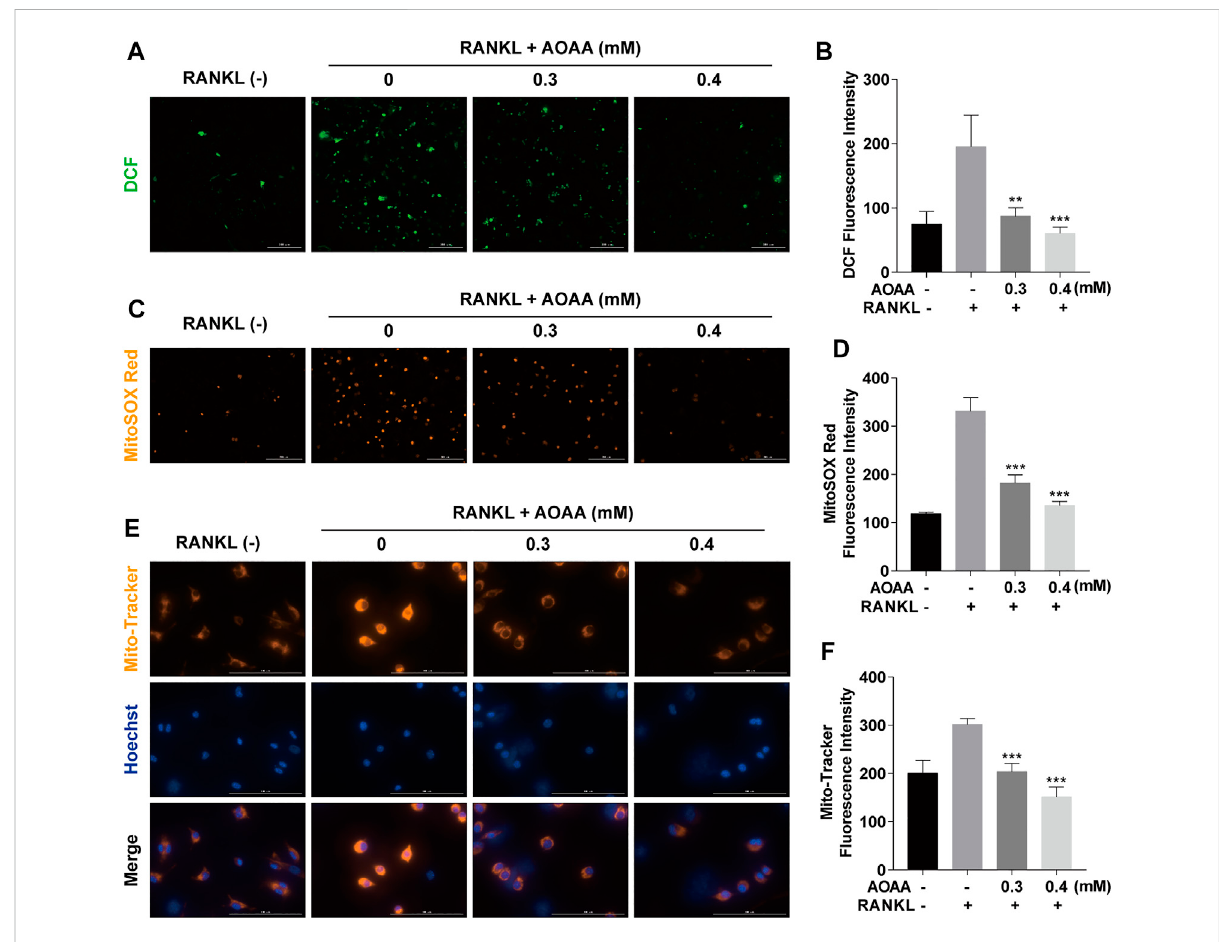
FIGURE 5 AOAA inhibits RANKL-induced ROS and attenuates mitochondrial function. (A) Representative fl uorescence images of RANKL-induced ROS (green, DCF, scale bar = 300 µM). (B) Quanti fi cation of the DCF fl uorescence intensity per fi eld. (C) Representative fl uorescence images of mitochondrial ROS (orange, MitoSOX Red, scale bar = 200 µM). (D) Quanti fi cation of the MitoSOX Red fl uorescence intensity per fi eld. (E) Representative fl uorescence images of mitochondrial membrane potential (orange, Mito-Tracker) and nuclei (blue, Hoechst, scale bar = 100 µM). (F) Quanti fi cation of the Mito-Tracker fl uorescence intensity per fi eld. All experimental data are expressedas mean ± SD ( n = 3). **p < 0.01, ***p < 0.001 compared with that in the AOAA − RANKL + group. One-way ANOVA was